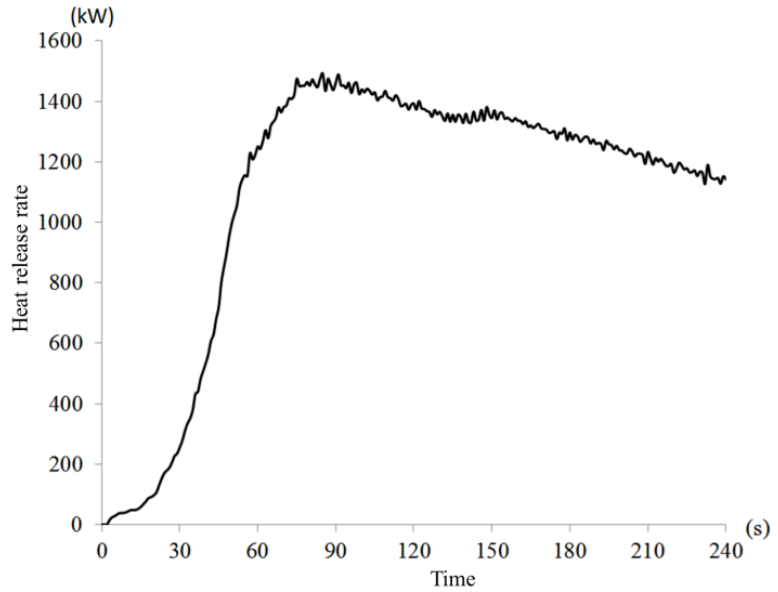
Figure 5. Heat release rate curve of the woodpile model in simulation.